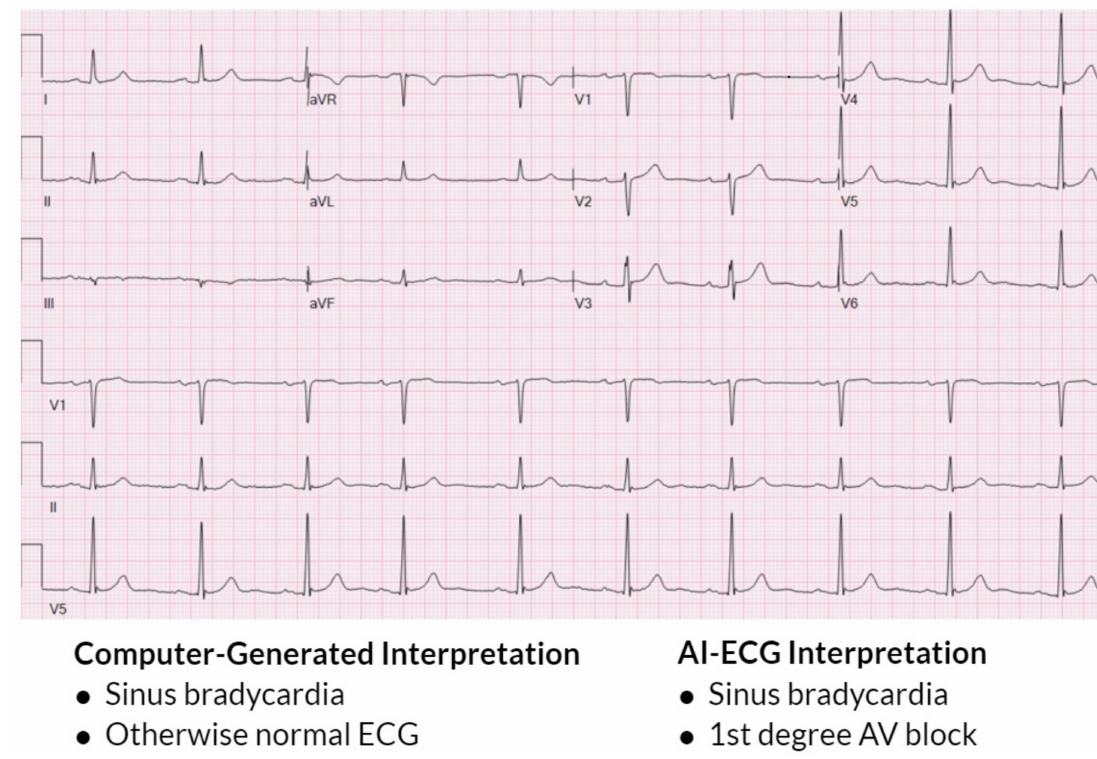
Figure 2. ECG showing traditional computer-generated interpretation versus AI-ECG interpretation. The AI-ECG interpre- tation provides a more specific and accurate interpretation of the ECG, while the computer-generated interpretation does not identify the first-degree AV block. While the AI-ECG algorithm is able to identify the AV conduction defect, it does not report a PR interval duration like traditional computer-generated